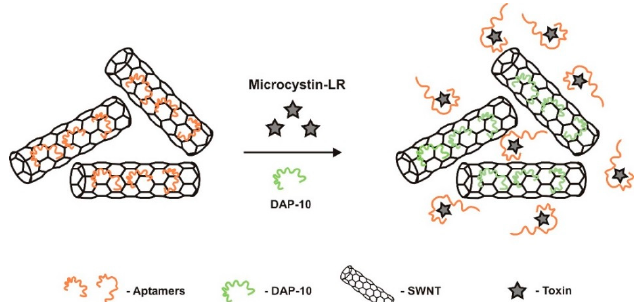
Figure 10. Optical aptasensor for ultrasensitive detection of microcystin-LR using single-walled carbon nanotubes (SWNTs), dapoxyl fluorescent dye, an aptamer with affinity to dapoxyl dye (DAP-10), and another aptamer with affinity to MC-LR, developed by Taghdisi et al.